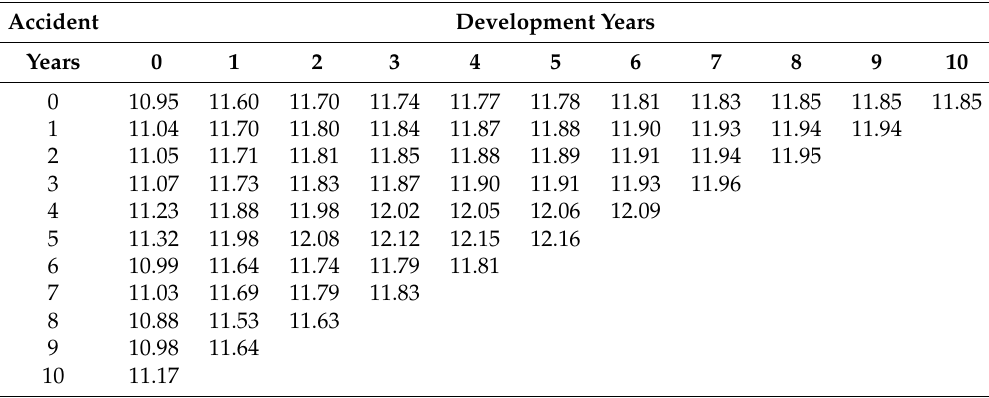
Table A3. Expected value of the parameter µ of the a-posteriori distribution.